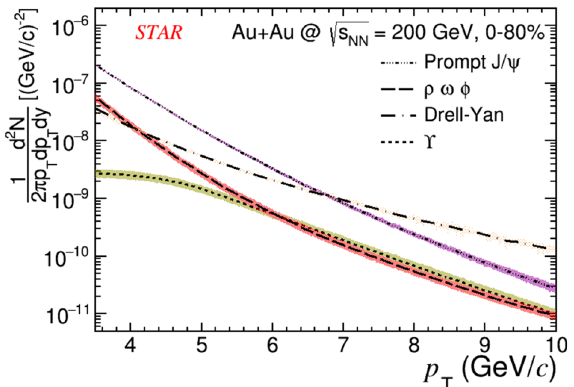
Fig. 7 The HFE invariant yield as a function of p T in 0–80% Au+Au √ s NN = 200 GeV. The error bars and the boxes represent collisions at statistical and systematic uncertainties, respectively